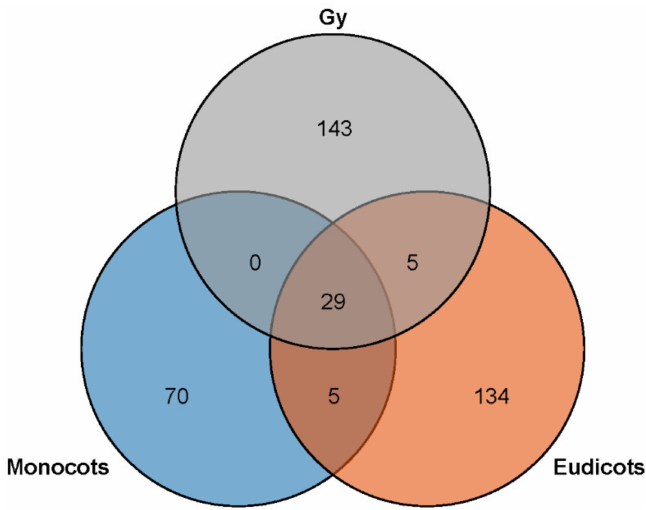
Figure 6. MiRNA families in monocots, eudicots, and